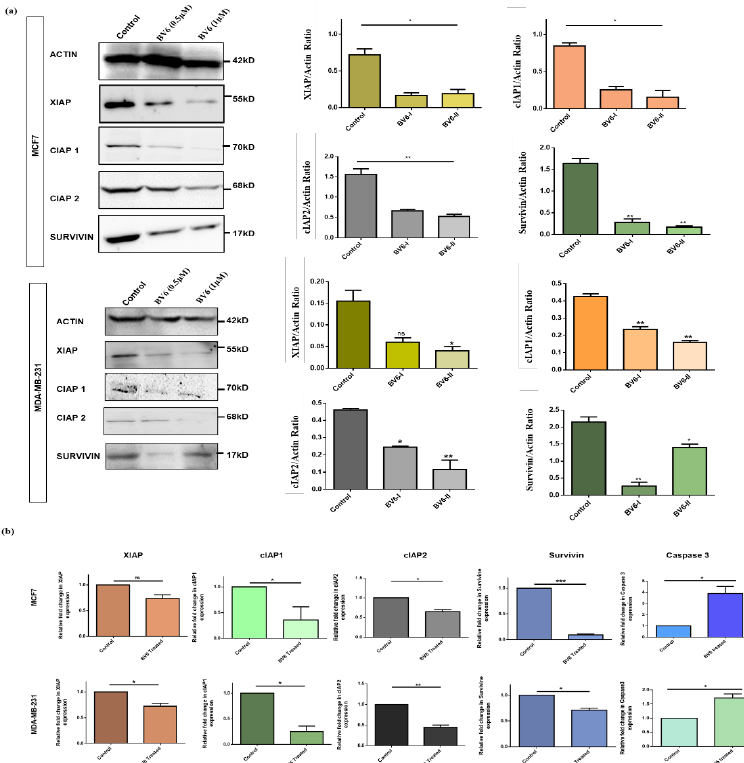
Figure 3. Relative protein and mRNA expression of IAPs in untreated and BV6 treated MCF7 and MDA-MB-231cells determined by Real-time PCR and western blotting, respectively. ( a ) Western Blot images showing the protein bands of untreated control and treated breast cancer cells with 0.5 μM and 1 μM of BV6. Histogram displaying the fold change in the XIAP cIAP1, cIAP2 and survivin protein expression levels normalized by Actin. ( b ) Fold change in XIAP, cIAP1, cIAP2, survivin and caspase3 mRNA expression levels normalized by Actin in both breast cancer cell lines. The experiments are carried out in triplicates displayed as mean ± SEM, and the data represented is statistically significant (*), (**), and (***) show p ˂ 0.05, p ˂ 0.01 and p ˂ 0.001, respectively.